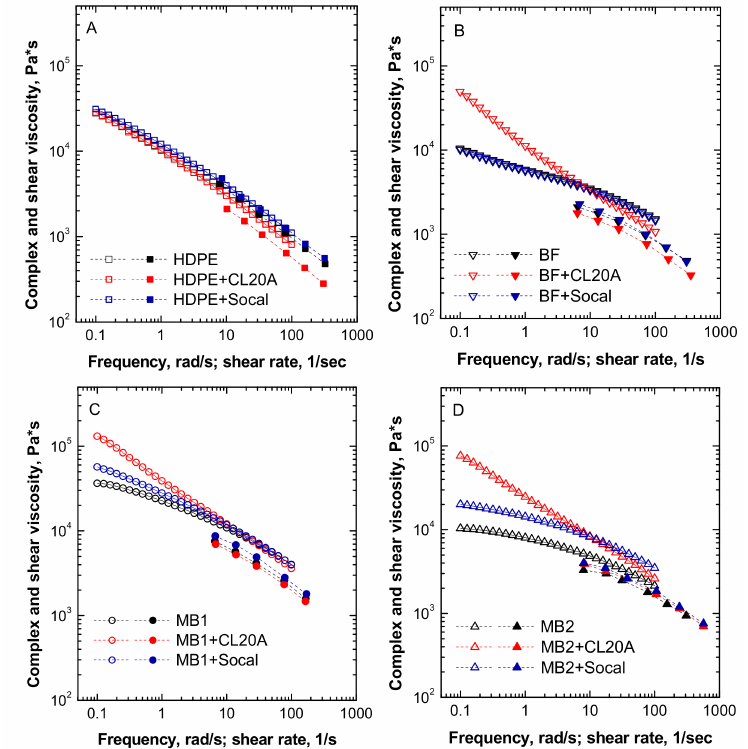
Figure 1. Complex and shear viscosity as a function of frequency and shear rate for all investigated materials: ( A ) HDPE-based systems, ( B ) BF-based systems, ( C ) MB1-based systems and ( D ) MB2- based